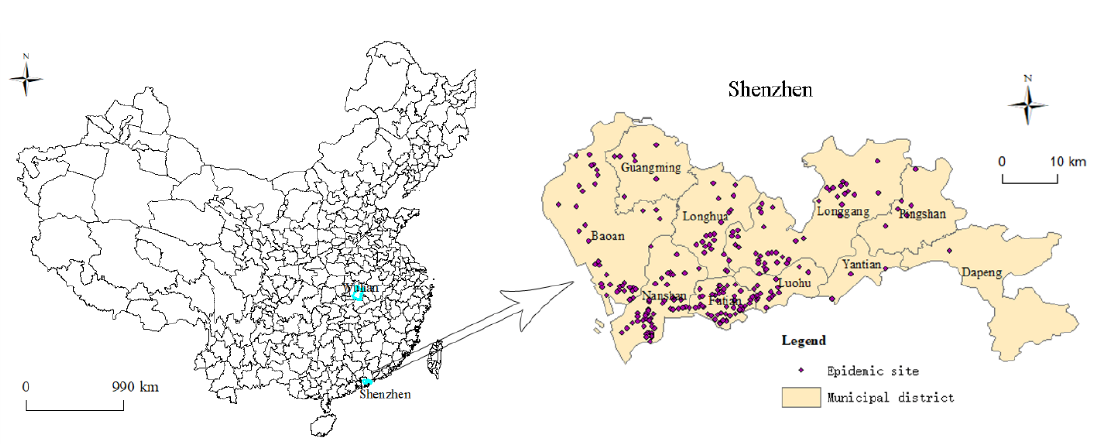
Figure 1. The study area and distribution of epidemic sites.